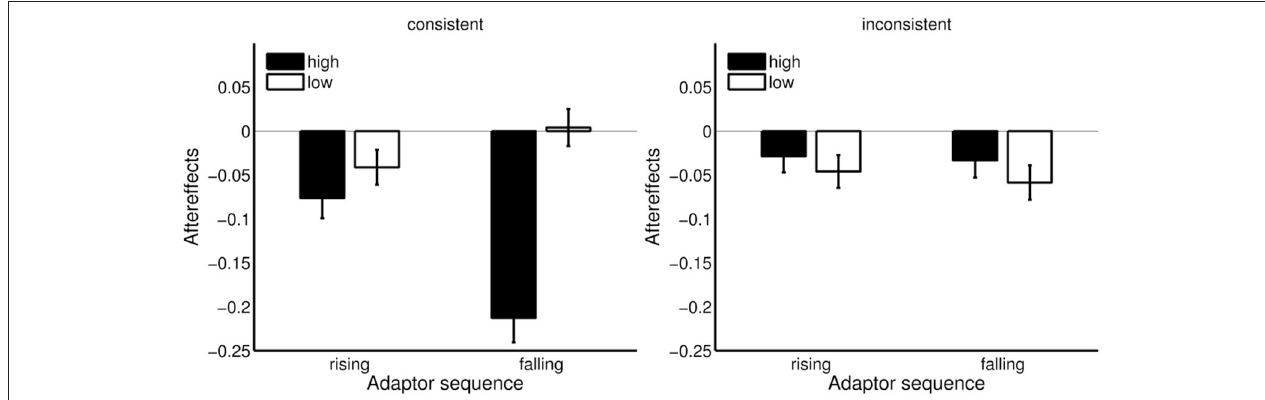
FIGURE 9 | Aftereffects for high and low Shepard tones and rising and falling adaptor sequences in the consistent and inconsistent condition. Rising adaptor sequence: Aftereffects = lower -response rate in control condition – lower -response rate in adaptation condition; falling adaptor sequence: Aftereffects = lower -response rate in adaptation condition – lower -response rate in control condition. Error bars represents the standard error of mean ( n =